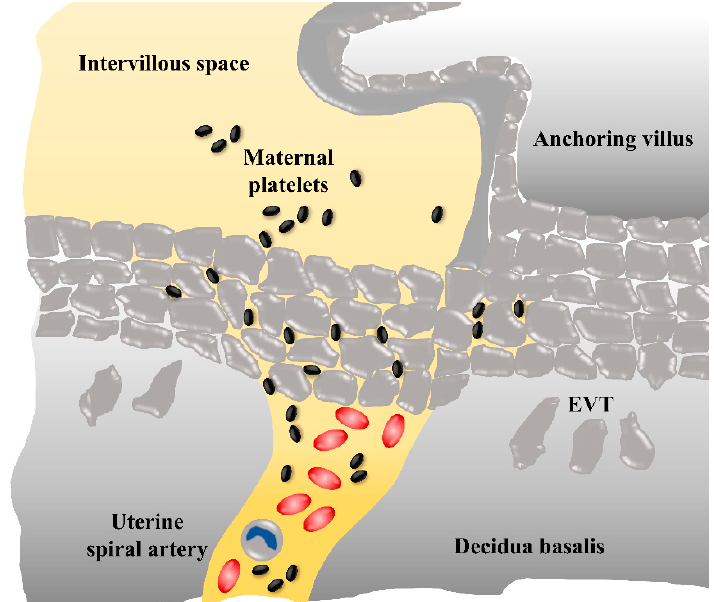
Figure 2. Potential route of maternal platelets into the early intervillous space. During early placenta development, maternal blood flow in uterine spiral arteries is obstructed by plugs of invaded extravillous trophoblasts (EVTs), however, maternal blood plasma and platelets can pass through narrow intertrophoblastic gaps, whereas erythrocytes and leukocytes are refrained from the intervillous space.